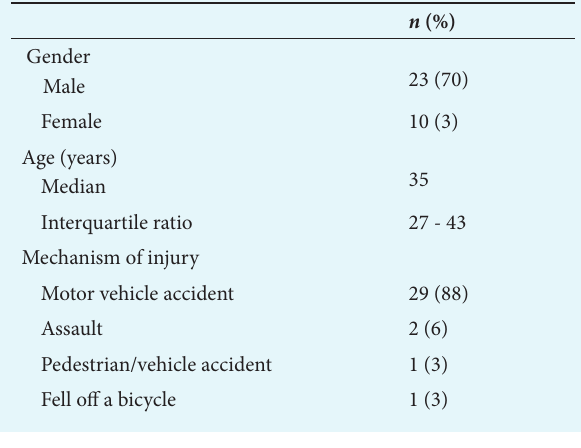
Table 1. Summary of demographic data and mechanism of injury